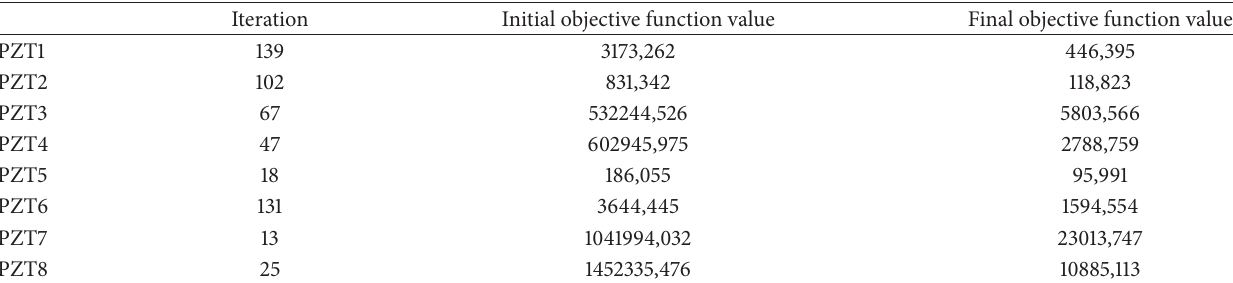
Table 4: Optimization results of the Gustafson-Kessel algorithm for the aircraft panel.